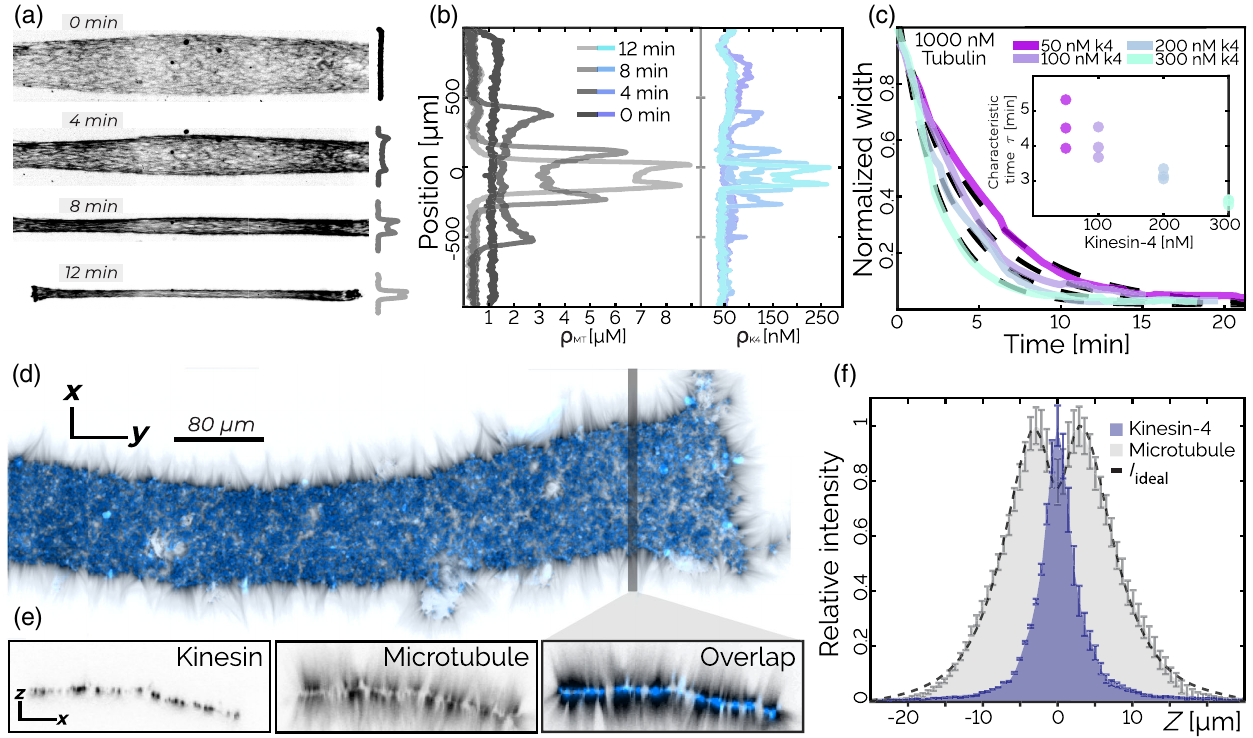
FIG. 2. Contracting gel: Globally contracting networks generate bilayer structures. (a) Kinesin-4-driven global contraction of labeled microtubules. (b) Microtubule and kinesin concentration as a function of the position along the chamber short axis reveals nonuniform density growth, with peaks at the sample edges. (c) The normalized width W n ð t Þ of a contracting network decays over time. Dashed lines are fits of Eq. (1). Inset: Contraction timescale τ decreases with kinesin concentration. Error bars indicate the standard error ( n ¼ 3 ). (d) The final structure of the contracted bilayer consists of a kinesin 2D sheet (blue) with microtubules (black) anchored to the surface and pointing along its normal. (e) x - z resliced at the shaded line. (f) Fluorescence intensity profile along the surface normal. The predicted microtubule fluorescence I (dotted black line) agrees with the measured fluorescence. Bars indicate the standard error over ideal 20 sections of 3 μ m